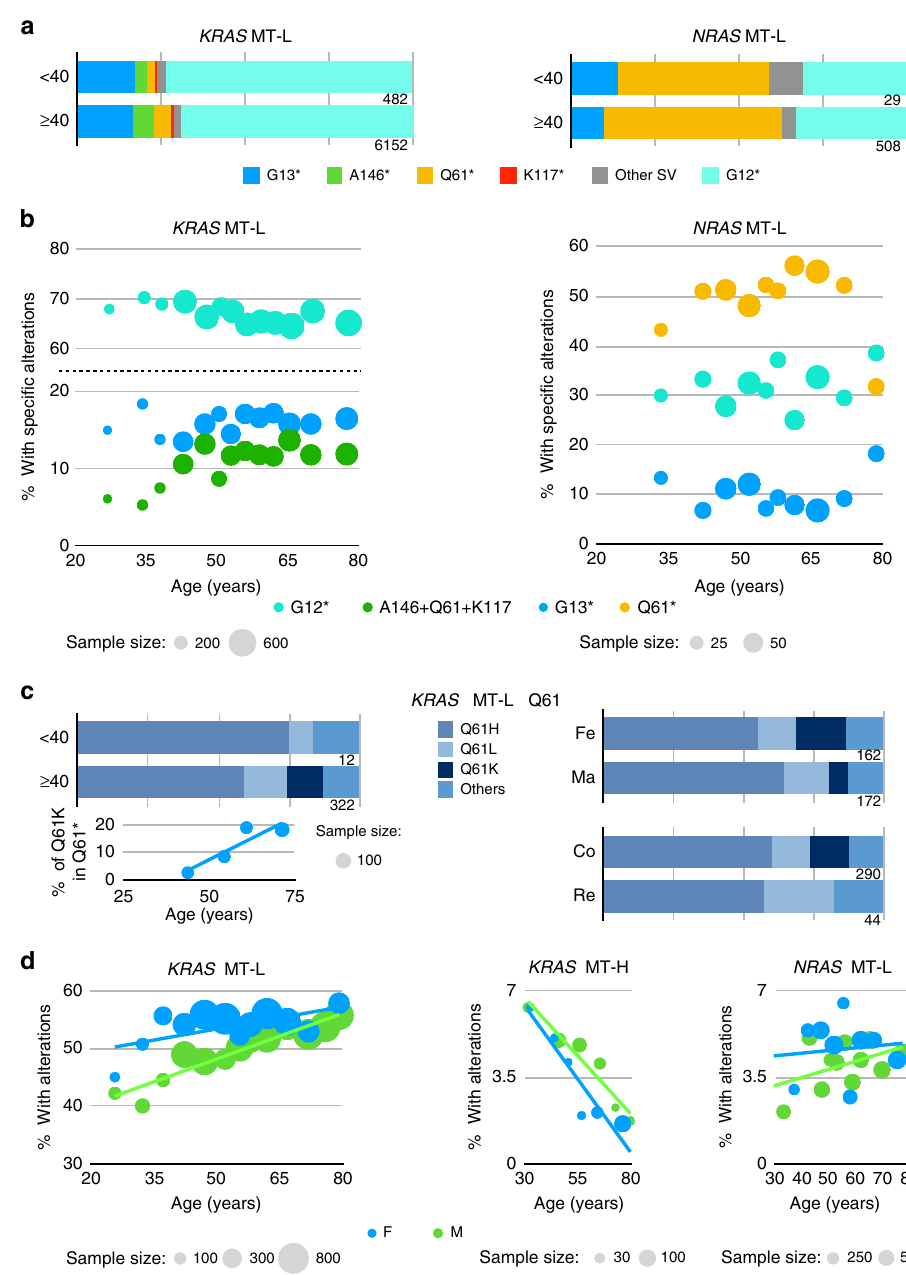
Fig. 4 Codon missense mutational pro fi le in KRAS , NRAS , and HRAS analyzed by age, gender, and colon versus rectal subsite. a Frequency of mutations in the indicated codons in KRAS and NRAS dichotomized based on age (<40 or ≥ 40 years) in MSI-H/low TMB (MT-L) colorectal cancer (CRC) patients. *Cumulative missense mutations. b Frequency of mutations in the indicated codons in KRAS and NRAS as a factor of age as a continuous variable in MT-L CRC patients. Lower abundance missense mutations affecting A146, Q61, and K117, are analyzed as a group. c Frequen c y of speci fi c missense mutations KRAS Q61 based on age (<40 or ≥ 40 years), gender, and tumor subsite (colon, CO, versus rectum, RE) in MT-L CRC patients. d Frequency of missense mutations considered as a factor of age as a continuous variable and gender in KRAS (in MT-L versus MSI-H/high TMB (MT-H) tumors) and NRAS (in MT- L ~33%) ( p = 2.9 E − 03 , Supplementary Fig. 4e). More speci fi c MT-H colon tumors, but not in rectal tumors ( p = 2.8 E − 03 for combined MT-L and MT-H groups, and p = 4.6 E − 03 for MT-L tumors) (Fig. 4c, right).